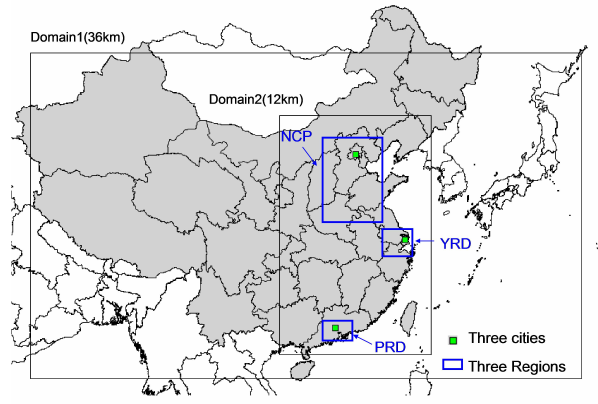
Fig. 4. Modeling domain and location of three